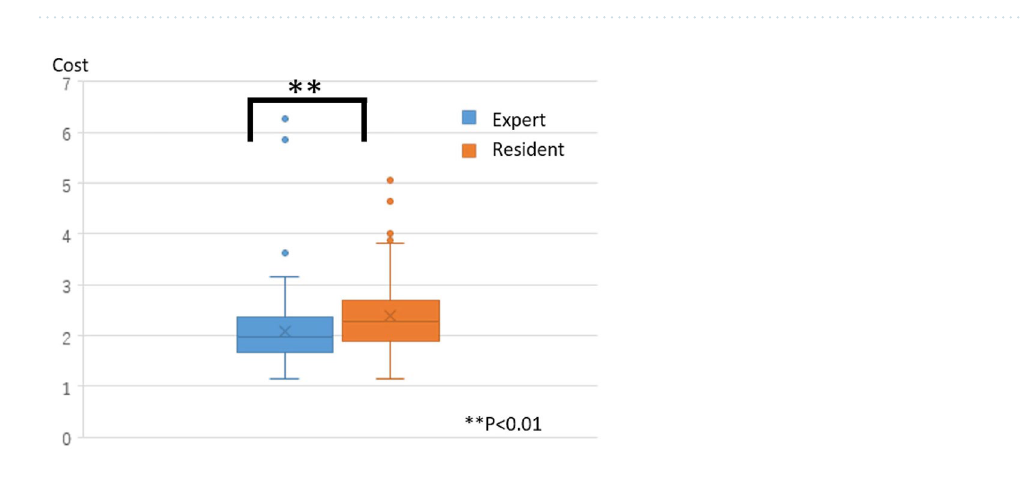
Figure 4. Algorithm of DTW barycenter averaging. Important work may be overlooked if the initial reference SPM is too short. Therefore, we chose the one with the longest operation time for reference. DTW dynamic time warping, SPM surgical process model.